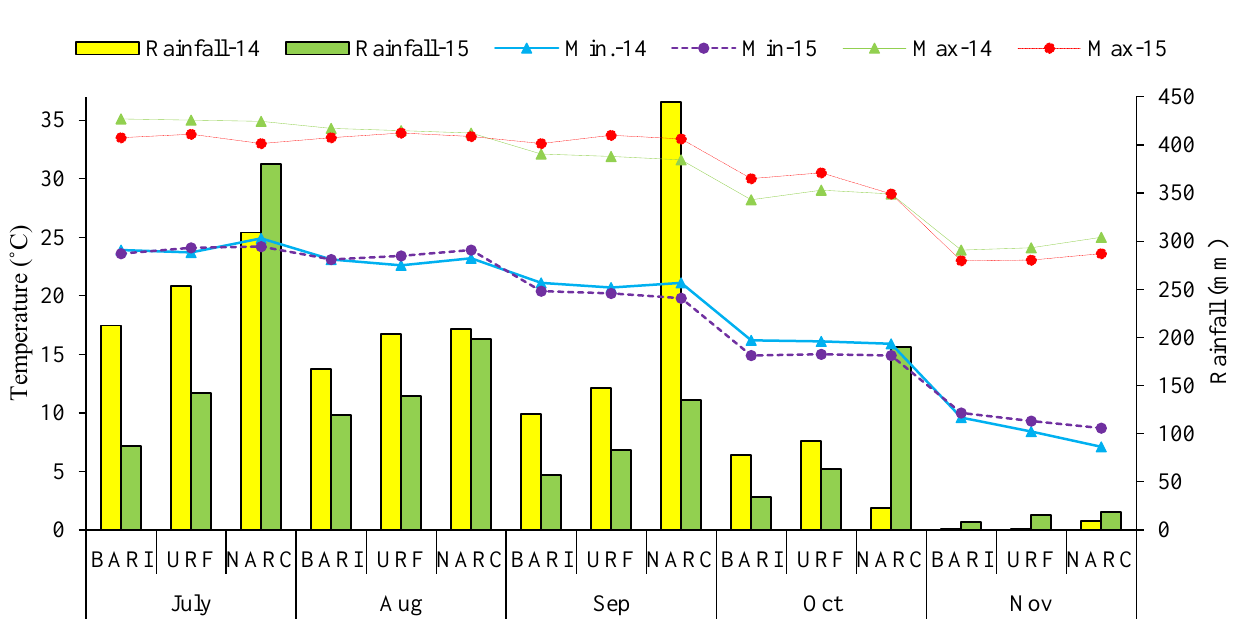
Figure 1. Agro-meteorological data of the experimental sites during 2014 and 2015.